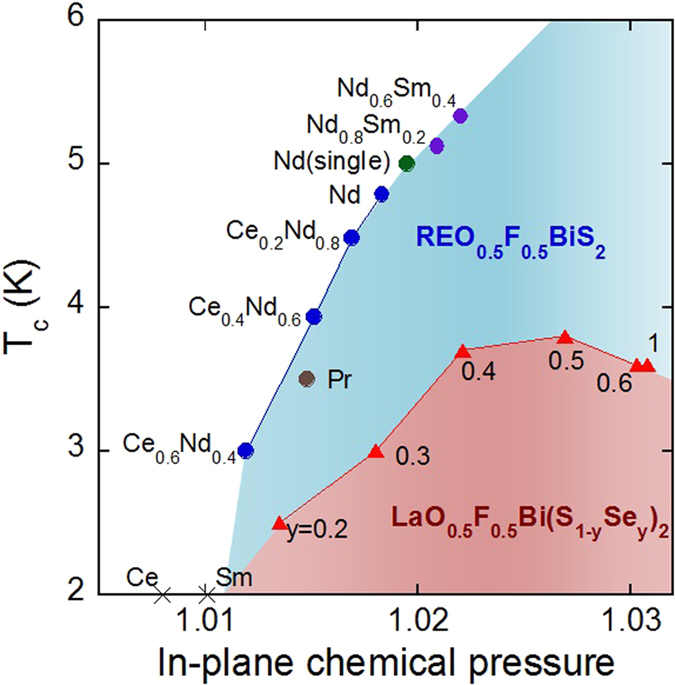
Relationship between Tc and degree of in-plane chemical pressure in REO0.5F0.5BiCh2.The data of Tc and the in-plane chemical pressure of Ce1−xNdxO0.5F0.5BiS2 and LaO0.5F0.5Bi(S1−ySey)2 are plotted with those of Nd0.8Sm0.2O0.5F0.5BiS2 and Nd0.6Sm0.4O0.5F0.5BiS2 (from this study), PrO0.5F0.5BiS216, and single crystals of NdO0.5F0.5BiS238, SmO0.5F0.5BiS218, and LaO0.5F0.5BiSe2 (y = 1)39. The curves for REO0.5F0.5BiS2 (blue) and LaO0.5F0.5Bi(S1−ySey)2 (red) lie on different regions.